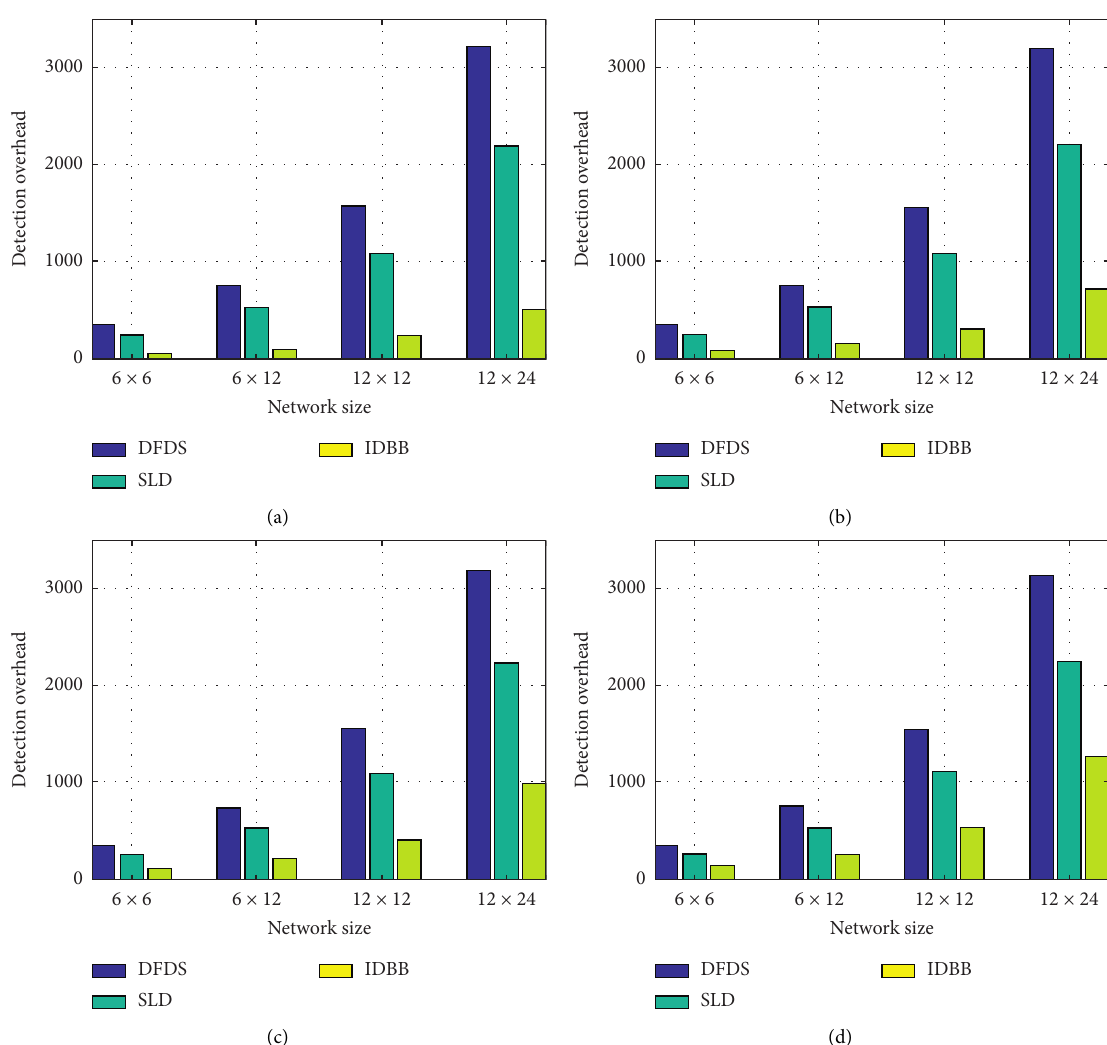
Figure 5: Variation of detection overhead with network size at each failure rate. (a) Failure rate � 15%. (b) Failure rate � 25%. (c) Failure rate � 35%. (d) Failure rate �